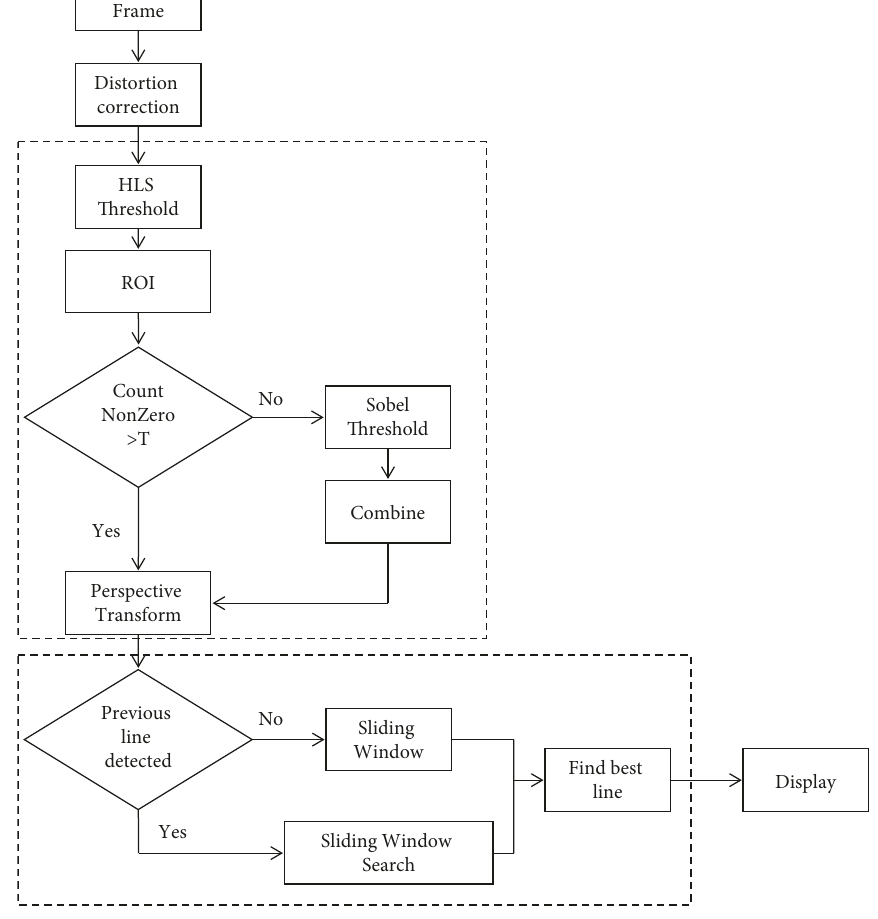
Figure 2: Diagram of the lane detection algorithm.